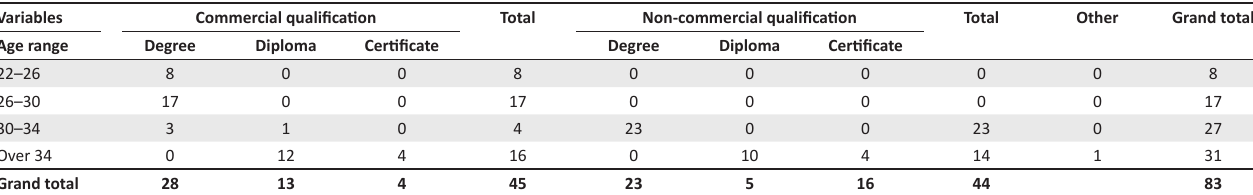
TABLE 1: Combined profile of the respondents.